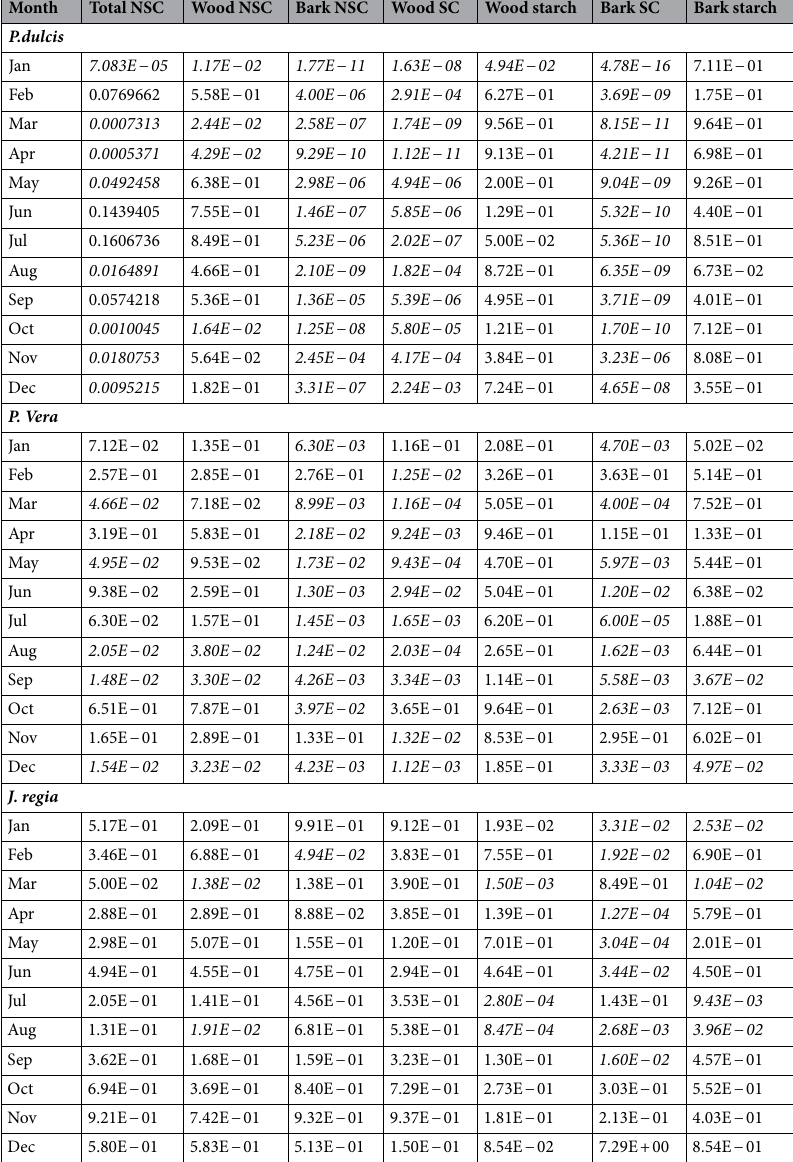
Table 5. Results of ANOVA analysis for presence of significant difference in content of carbohydrates between months in consecutive years. Italics denotes p <